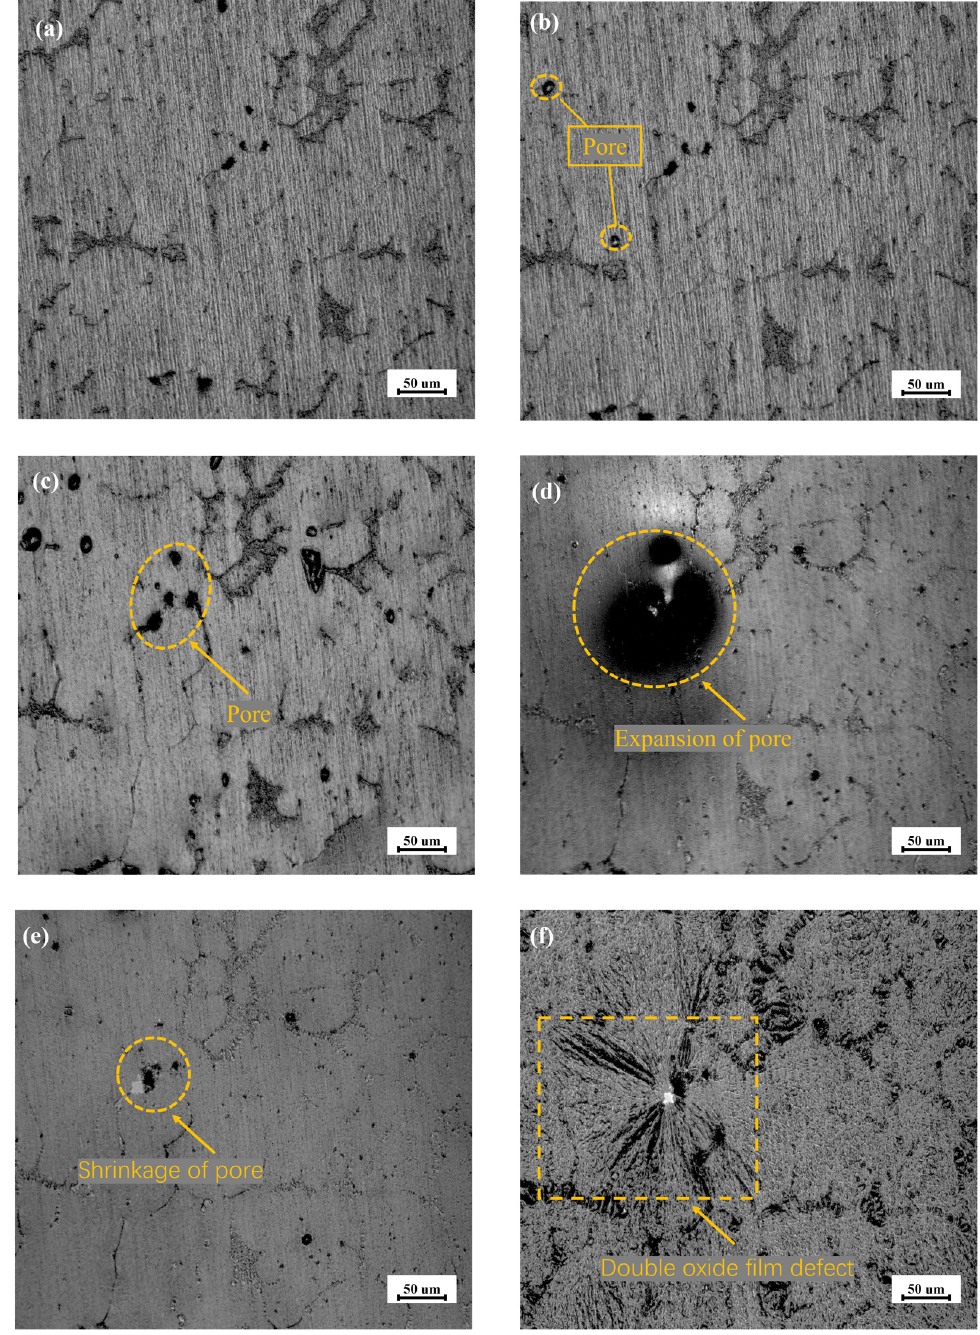
Figure 5. In-situ real-time observation of structural changes in oxide film of AA6111 alloy melt from room temperature to 950 K: ( a ) Room temperature, ( b ) 773 K, ( c ) 833 K, ( d ) 875 K, ( e ) 930 K, ( f ) 950 K.